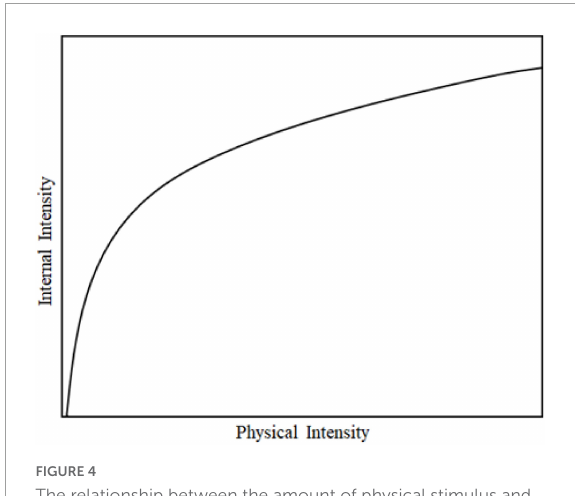
FIGURE4 The relationship between the amount of physical stimulus and the subjective internal response.